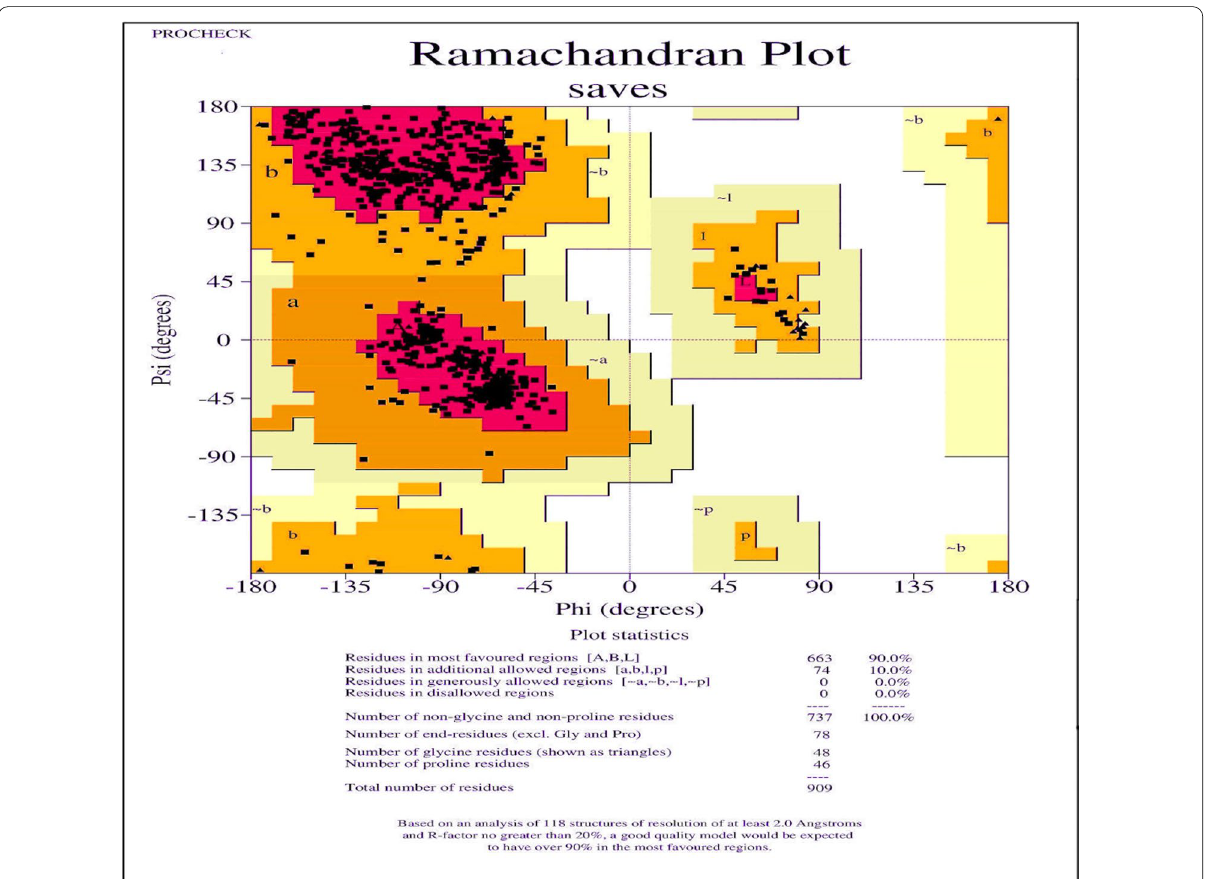
Fig. 6 Evaluation & Validation of predicted PDB model: where the Ramchandran Plot revealed that 90% of all modeled residues lie energetically in the most favored regions. According to PROCHECK